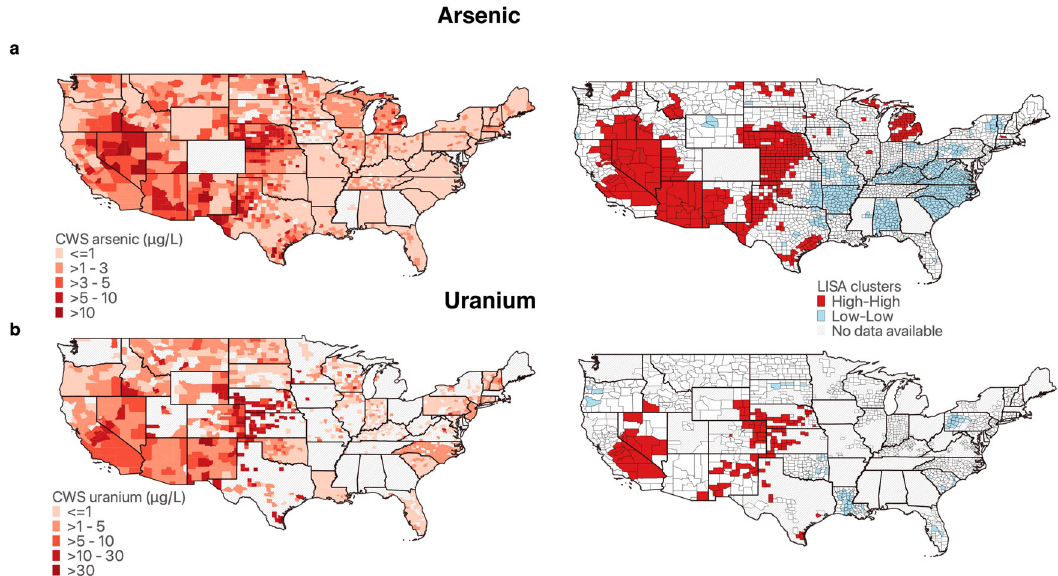
Fig. 1 | Nationwide spatial distribution of county-level community water sys- tem (CWS) metal concentrations and local indicators of spatial associations (LISA) clusters. a Arsenic . b Uranium. County-level CWS metal concentrations were originally developed and described by Nigra et al. (2020) and Ravalli et al. (2022) and are categorized and colored in red scale. The highest concentration